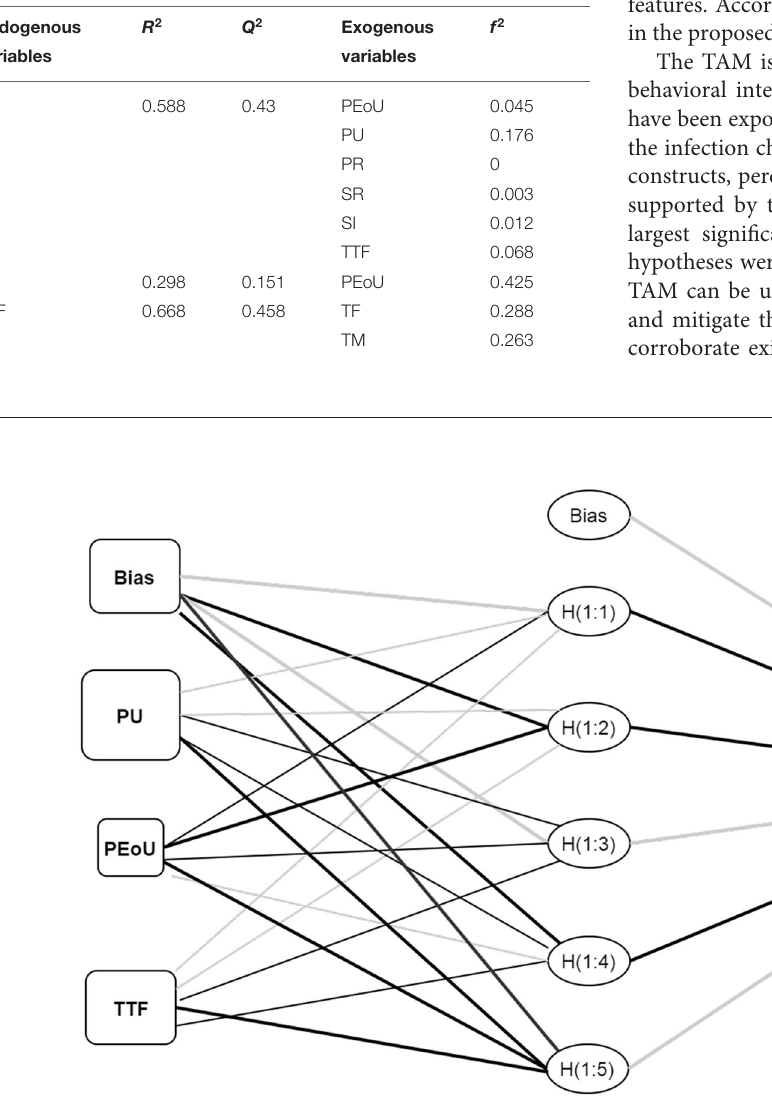
Frontiers in Public Health |